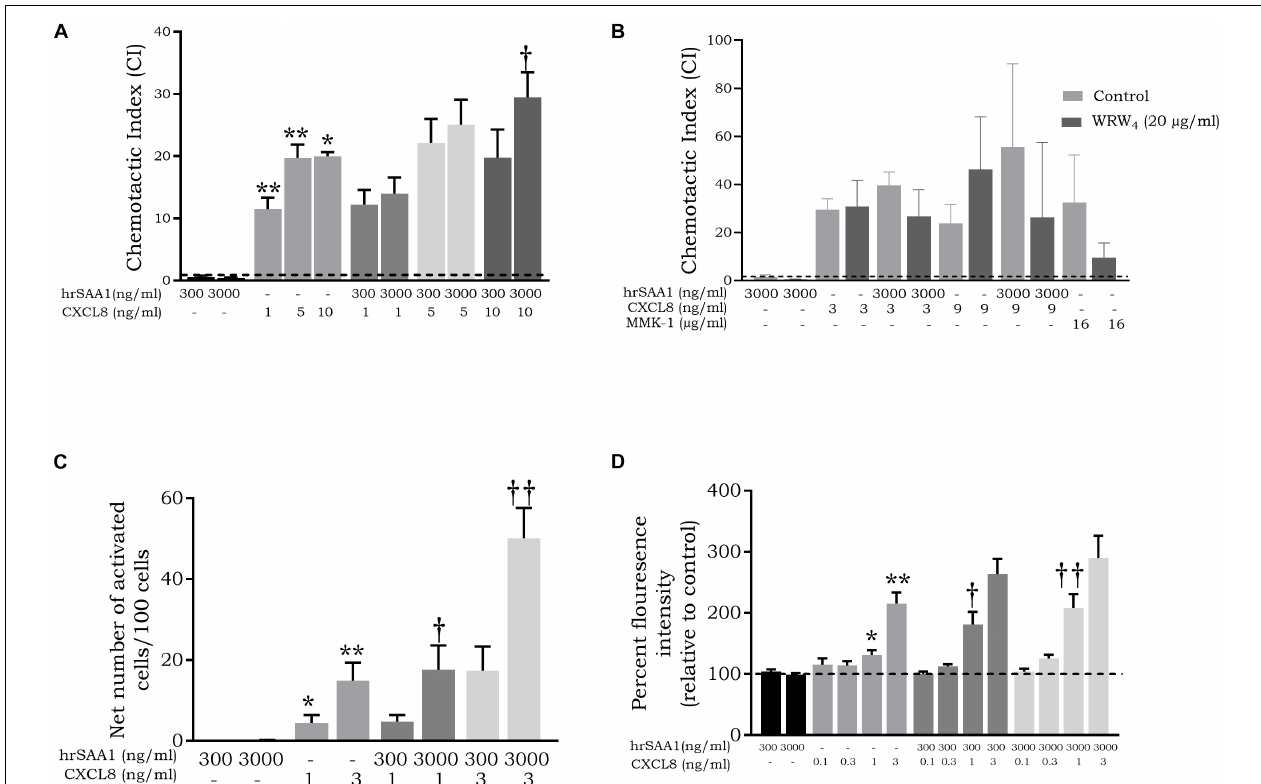
FIGURE 9 | hrSAA1 retains the capacity to synergize with CXCL8 in the in vitro attraction and activation of neutrophils. (A) Homogenous rSAA1 (hrSAA1, 300 or 3000 ng/ml, 25 or 250 nM) and CXCL8 (1–10 ng/ml, 0.12–1.2 nM) were added to the lower compartment of a Boyden microchamber either alone or in combination. Freshly isolated neutrophils were added to the upper compartment and allowed to migrate for 45 min. The chemotactic potencies are expressed as mean chemotactic index (+SEM) derived from six independent experiments. Control recruitment is indicated by a dashed line (---). (B) MMK-1 (16 µ g/ml, 9930 nM), hrSAA1 (3000 ng/ml, 250 nM), CXCL8 (3 or 9 ng/ml, 0.36 or 1.07 nM) or a combination of hrSAA1 and CXCL8 were added to the lower compartment of a Boyden microchamber. Freshly isolated neutrophils in the presence or absence of the FPR2 antagonist WRW 4 (20 µ g/ml, 18110 nM) were added to the upper compartment and allowed to migrate for 45 min. The chemotactic potencies are expressed as mean chemotactic index + SEM and are derived from three independent experiments. Control recruitment is indicated by a dashed line (---). (C) Neutrophils were stimulated (3 min) with homogenous hrSAA1 (300 or 3000 ng/ml, 25 or 250 nM), CXCL8 (1 or 3 ng/ml, 0.12 or 0.36 nM) or a combination of hrSAA1 and CXCL8. Data from six independent experiments are expressed as the net percentage of activated cells (blebbed and elongated cells) (+SEM). (D) Freshly isolated neutrophils were stimulated for 30 s with different concentrations of hrSAA1, CXCL8 or a combination of hrSAA1 and CXCL8. Following stimulation, cells were stained with Alexa Fluor 555 Phalloidin. Control actin polymerization is indicated by a dashed line (---). Results are presented as the mean percent florescence intensity relative to buffer-stimulated cells (+SEM) and are derived from six independent experiments. Significant neutrophil recruitment/activation in comparison to control is indicated by asterisks (Mann-Whitney U -test; * p -value < 0.05, ** p -value < 0.01). Significant synergy between hrSAA1 and CXCL8 in neutrophil activation/recruitment is indicated by daggers (Mann-Whitney U -test; † p -value < 0.05, †† p -value < 0.01).